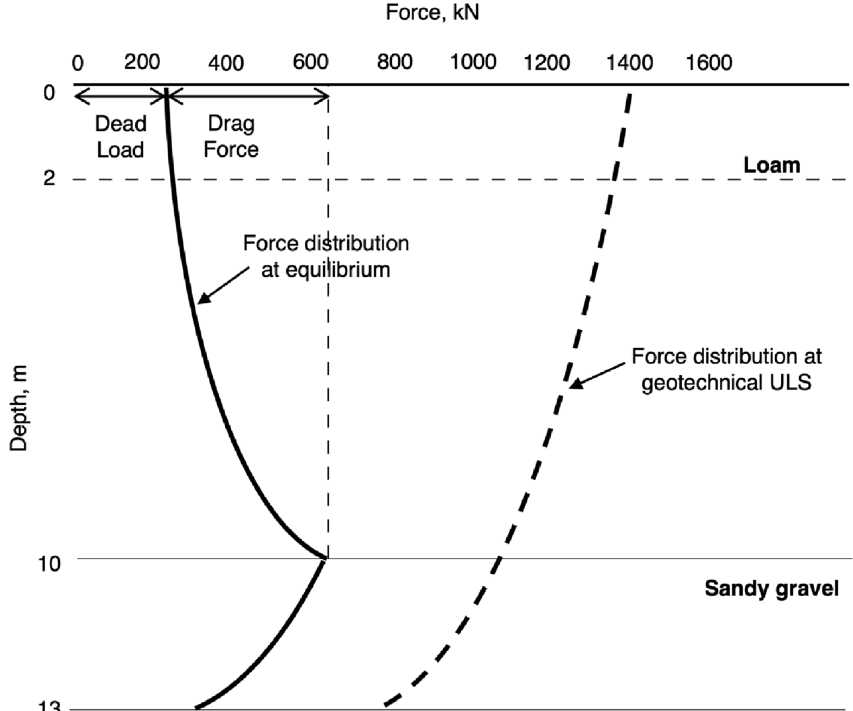
Fig. 4 Pile force distribution at equilibrium and geotechnical ULS for Case III